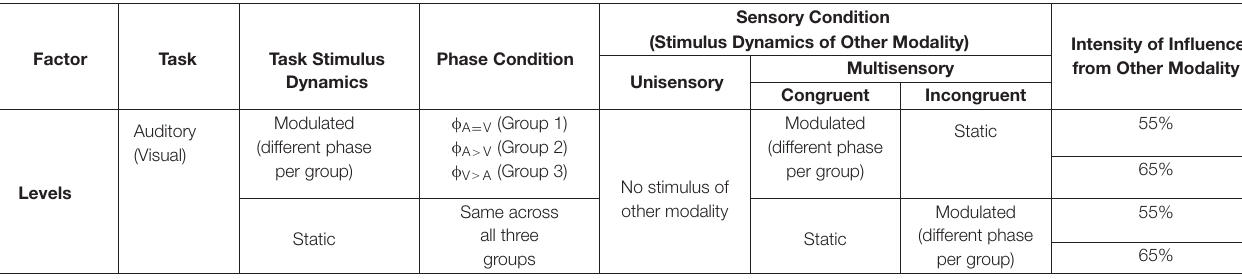
TABLE 1 | Overview of the experimental